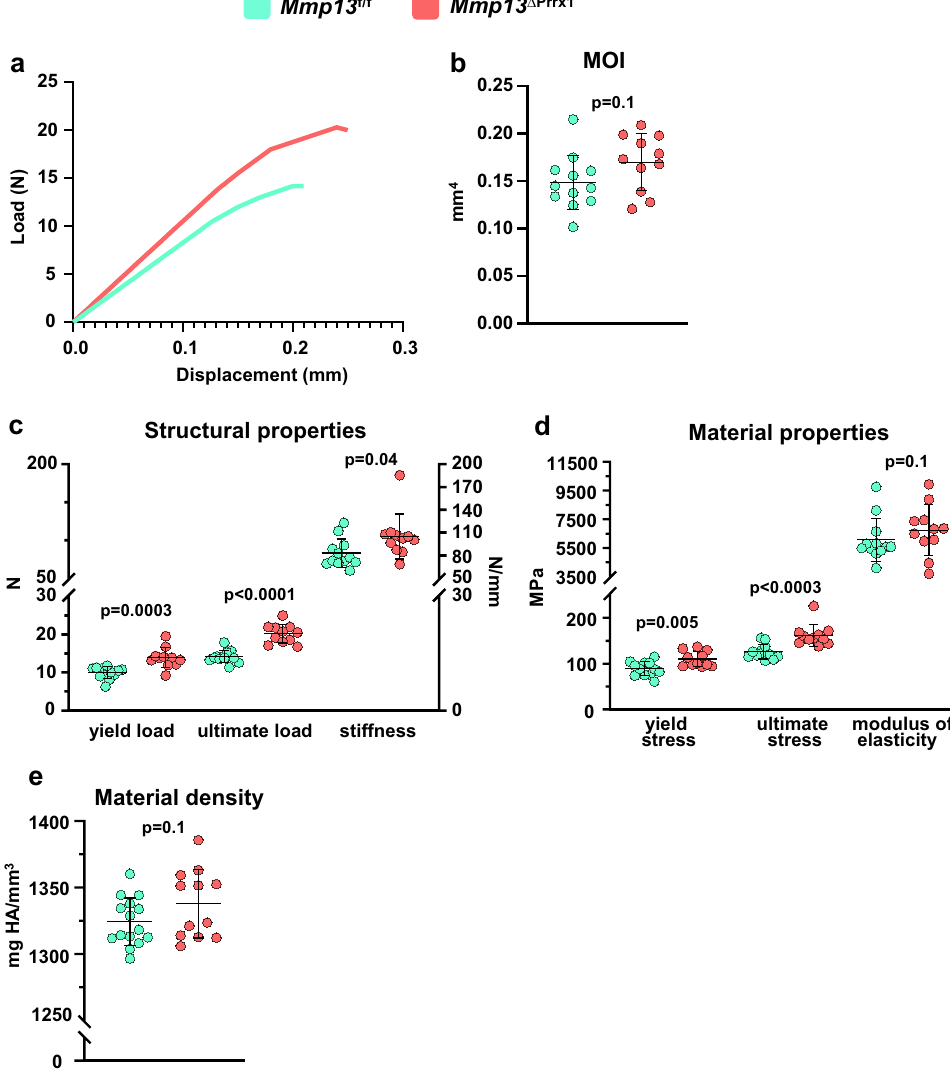
Figure 6. Mmp13 deletion increase whole-bone strength in female mice. Femurs from 6-month-old Mmp13f. /f and Mmp13 ∆Prrx1 female mice were tested for bone strength by 3-point bending. ( a ) Representative load versus displacement curve showing that femur of Mmp13 ∆Prrx1 mice are more resistant than control littermates. ( b ) Moment of inertia, ( c ) Structural properties, and ( d ) Material properties. ( e ) Material density by micro-CT. Data represent mean ± S.D. (n = 12–11 mice/group); P values by student t